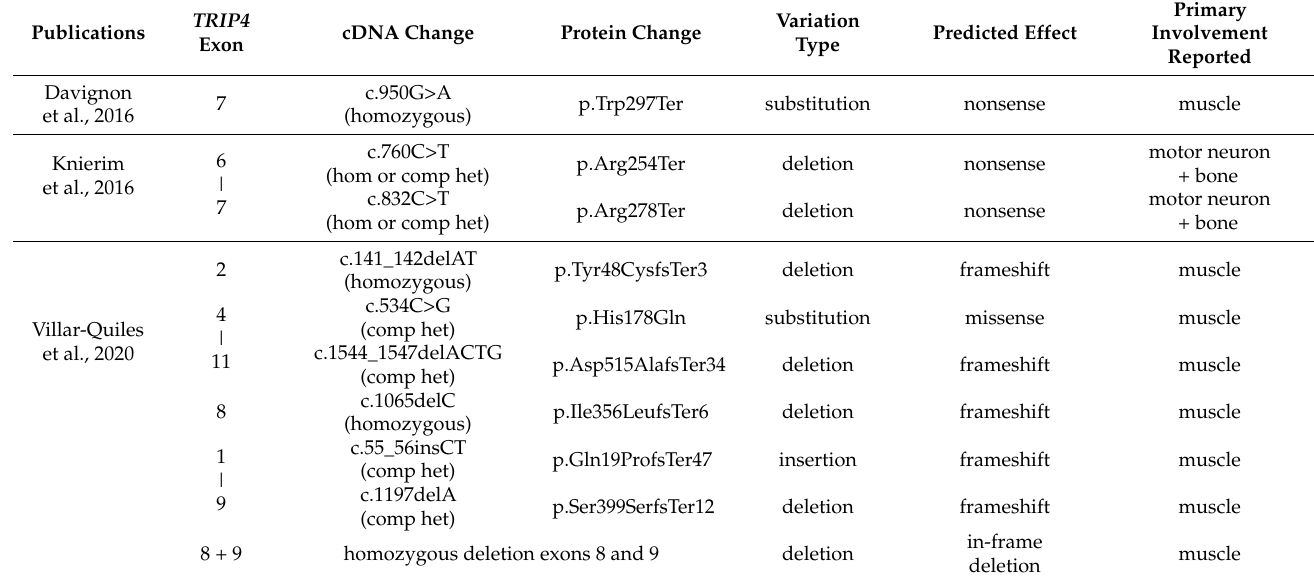
Table 1. Summary of the 10 TRIP4 mutations identified so far. Some patients were compound heterozygous (comp het) for a missense and a truncating mutation (in exons 4 + 11) or for two different truncating mutations (in exons 1 + 9 or 6 + 7). Publications Predicted Effect